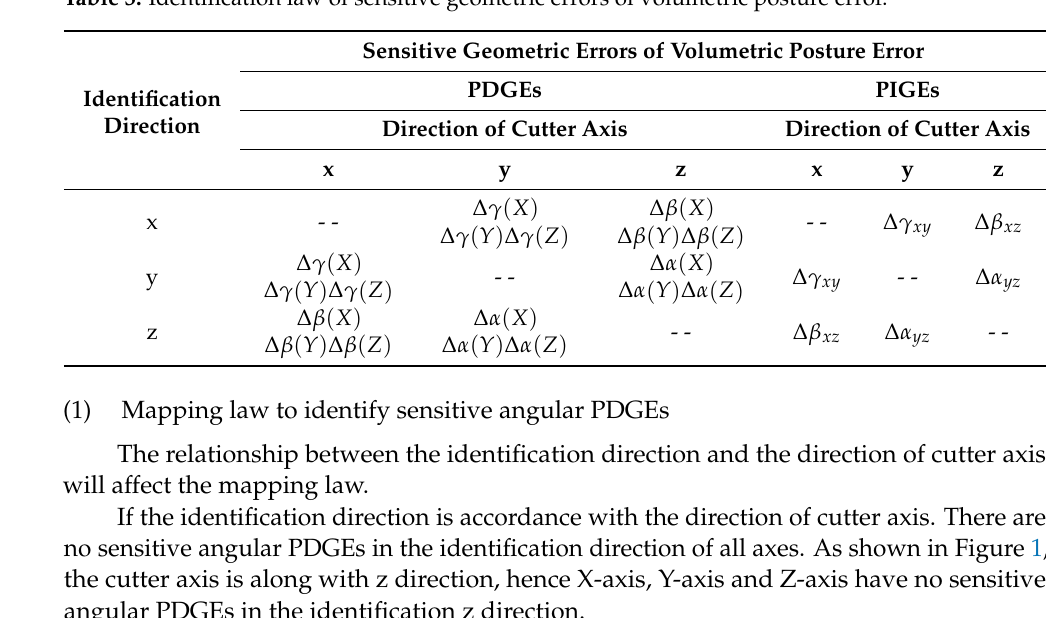
Table 3. Identification law of sensitive geometric errors of volumetric posture